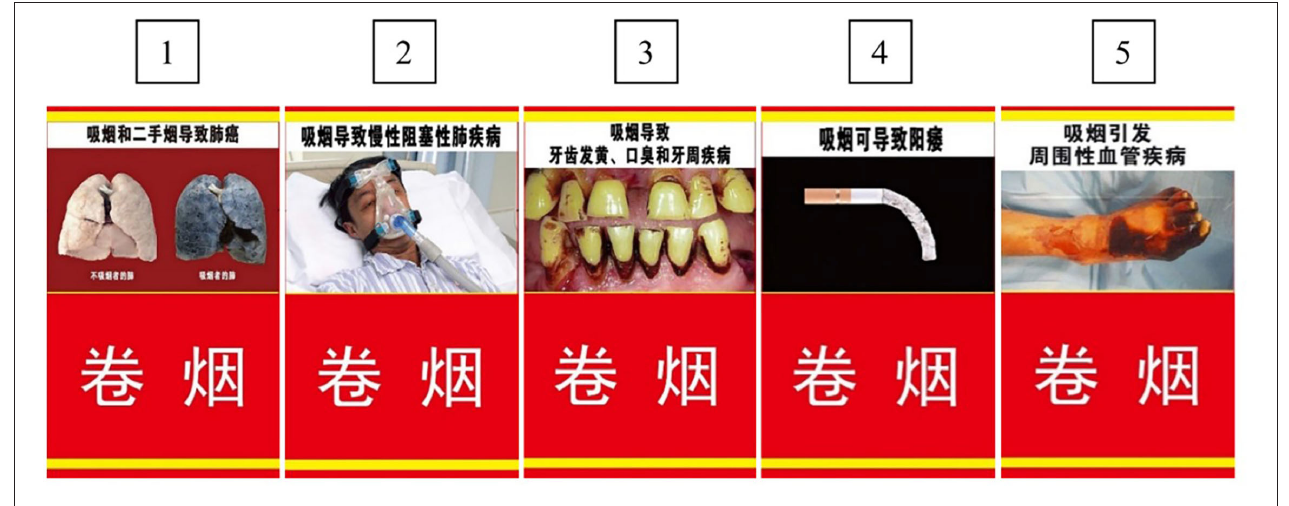
FIGURE 5 | Five pictures showing adverse effects of smoking.